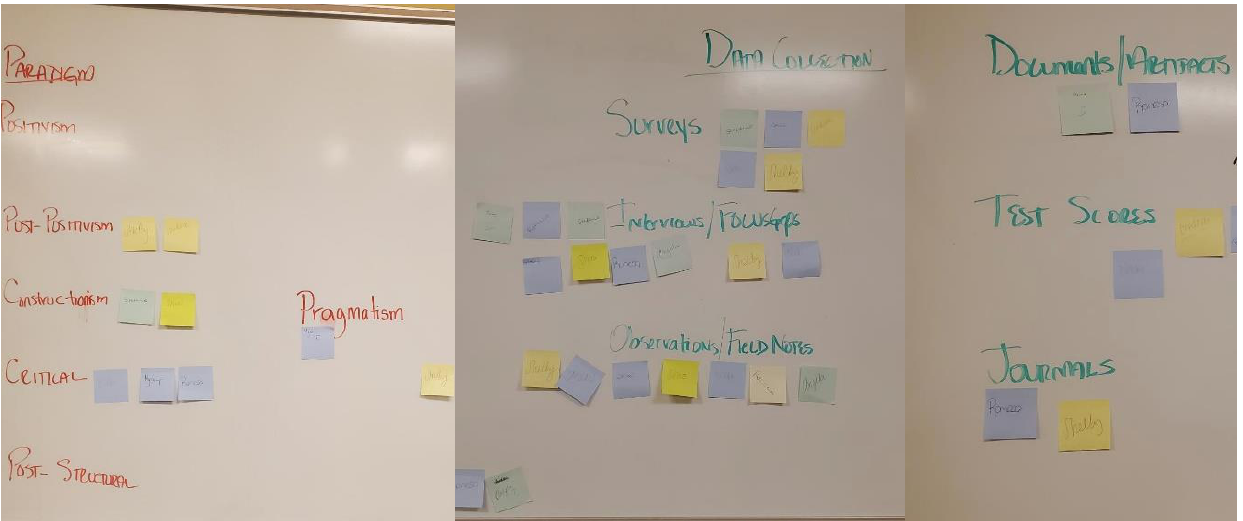
Figure 1. Board of Candidate